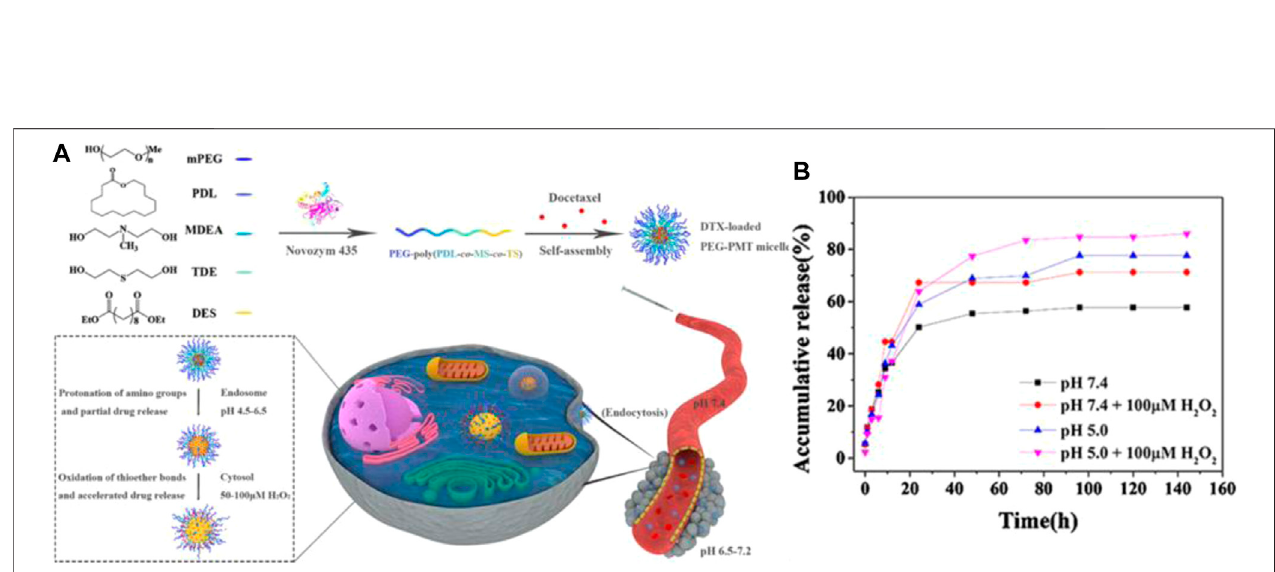
FIGURE 4 | Illustration ofROS-responsive polymers containing thioether in the tail chains and the resulting chemical structure. (A) Curves of tumor volumetreated withdifferentS-PC – basedliposomes. (B) Bodyweightoftumor-bearingmice. (C) CurvesoftumorweighttreatedwithdifferentS-PC – basedliposomes(Duetal.,2019). Copyright 2019, the American Chemical Society.